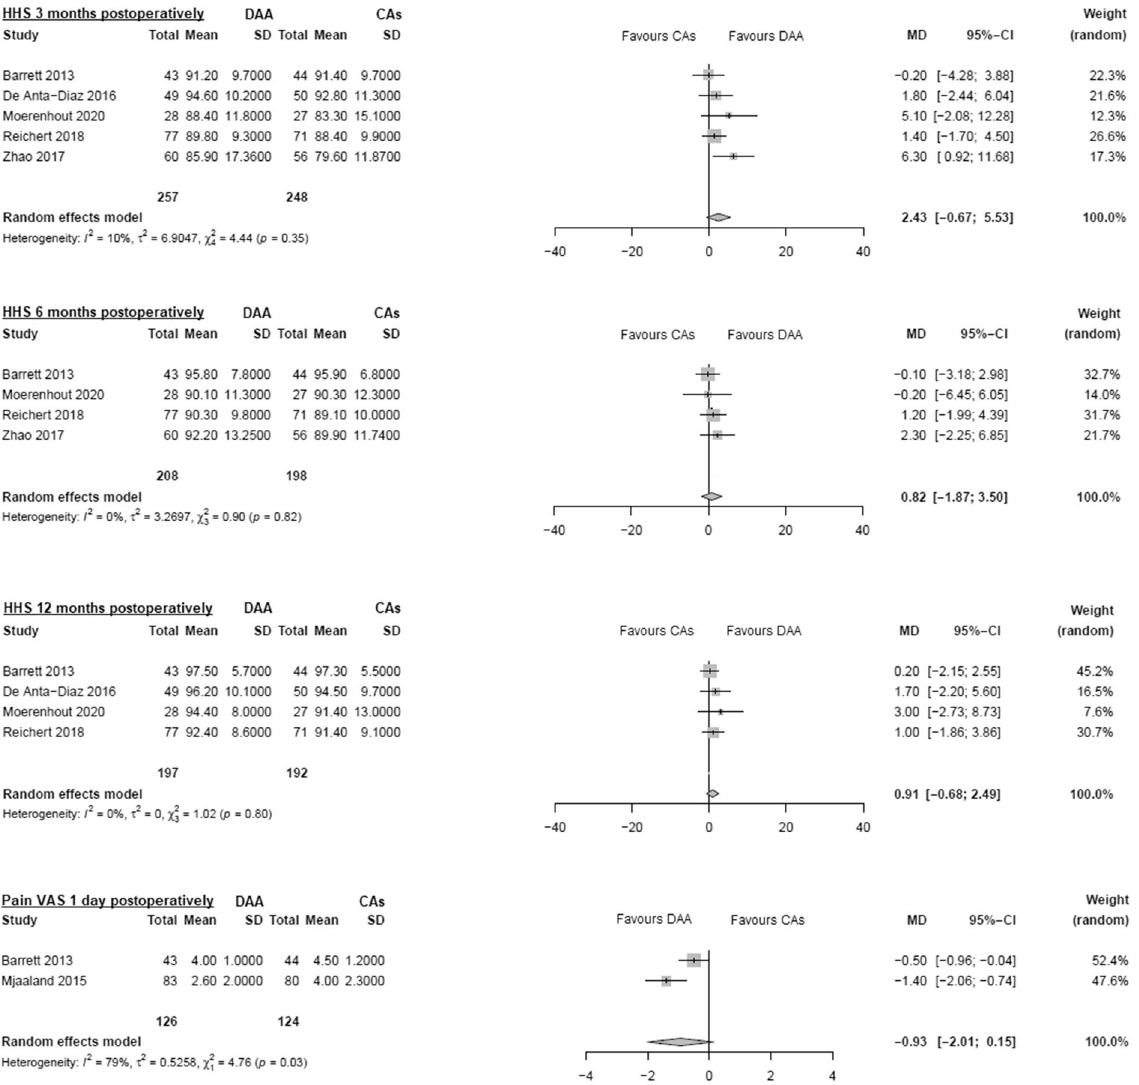
Figure 3. Comparison of the HHS 3, 6 and 12 months postoperatively, pain VAS 1 day postoperatively. DAA direct anterior approach, CAs conventional approaches, SD standard deviation, MD mean difference, CI confidence